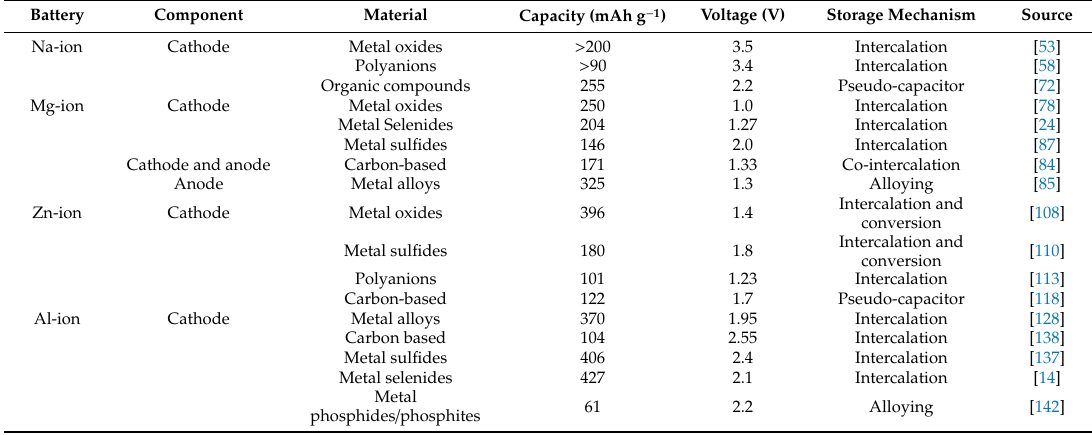
Table 2. Overview of the electrode types per battery and their corresponding capacities and voltages.